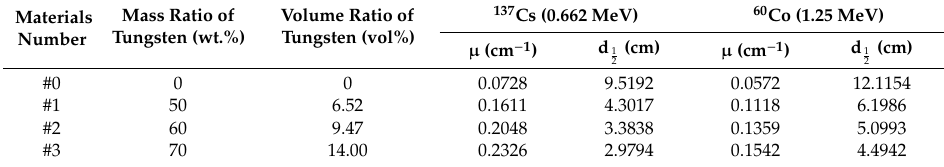
Table 5. Attenuation characteristics of the new gamma-ray shielding PEEK / tungsten composites.